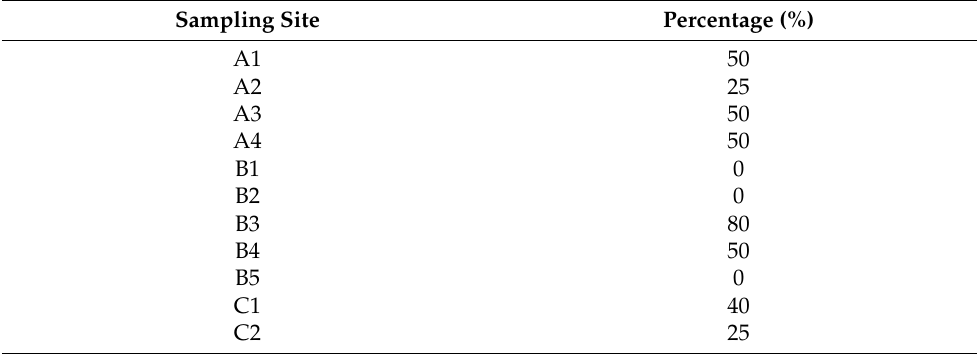
Table 5. Percentage (%) of samples with DAR value higher than